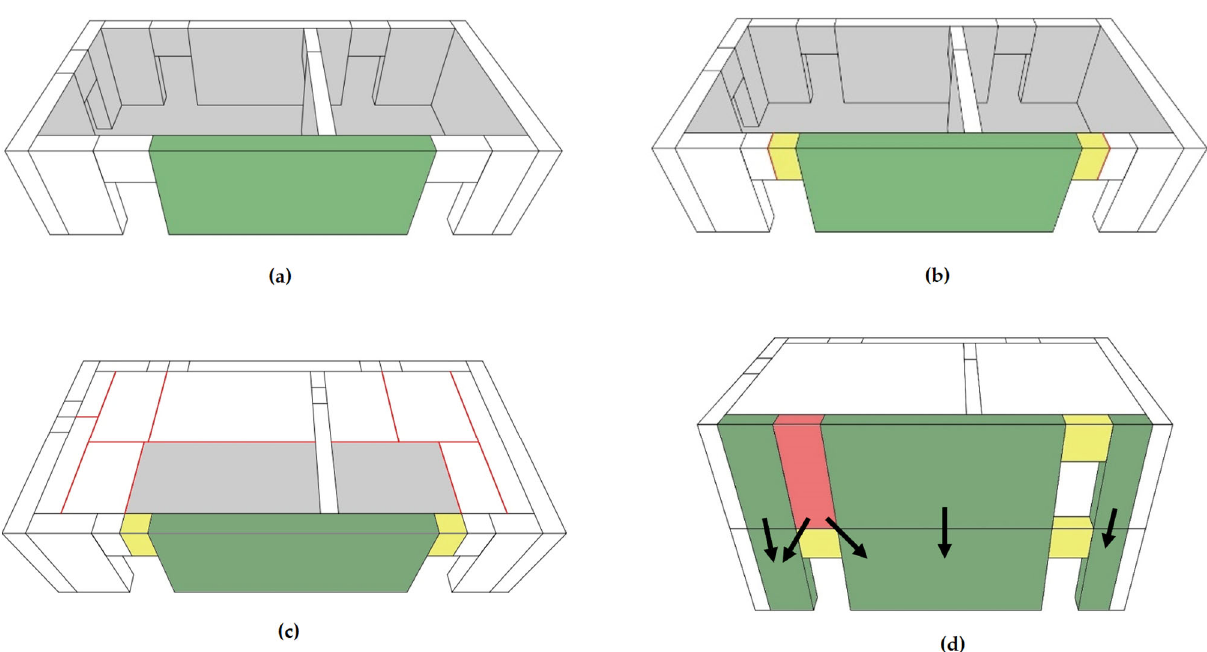
Figure 8. Load analysis and calculation of stresses, as the sum of ( a ) self-weight, ( b ) the weight of masonry spandrels, ( c ) the loads from floors and ( d ) the loads from the overlying walls.